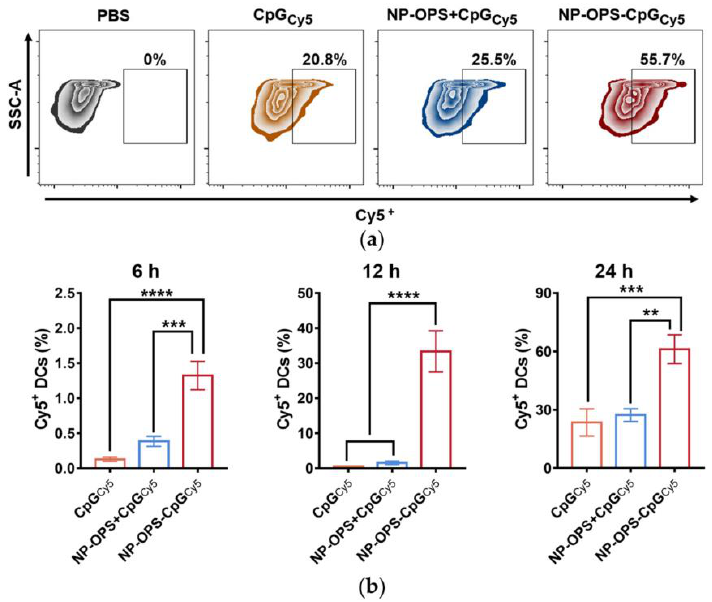
Figure 4. DC2.4s phagocytosis of the nanovaccine. ( a ) Representative flow cytometry gating for evaluating Cy5 + production in DC2.4s. ( b ) DC2.4s phagocytosis of the bioconjugate nanovaccine 6